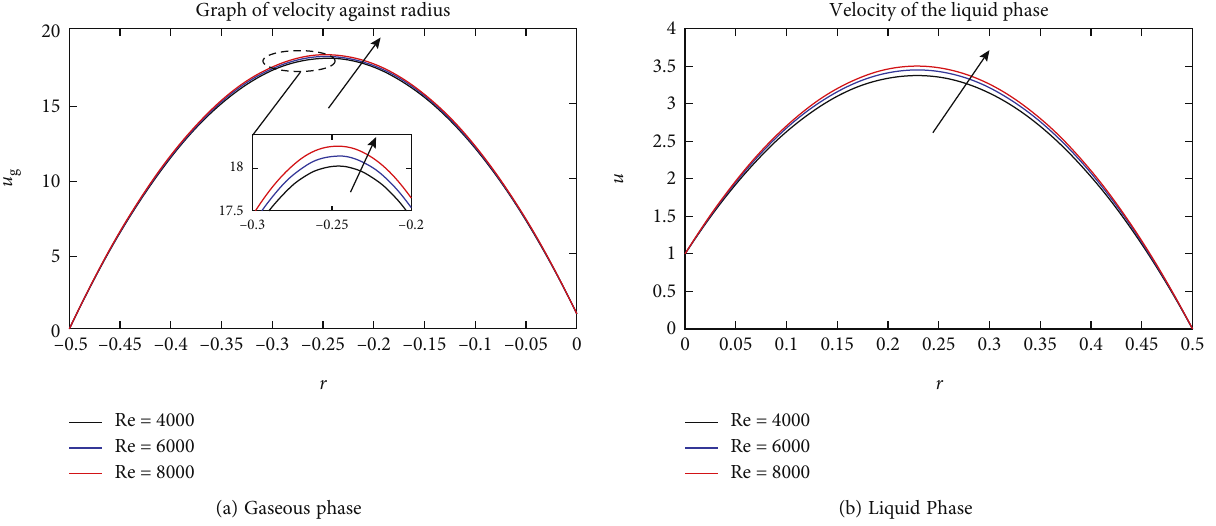
Figure 2: E ff ect of Reynolds Number on Velocity.